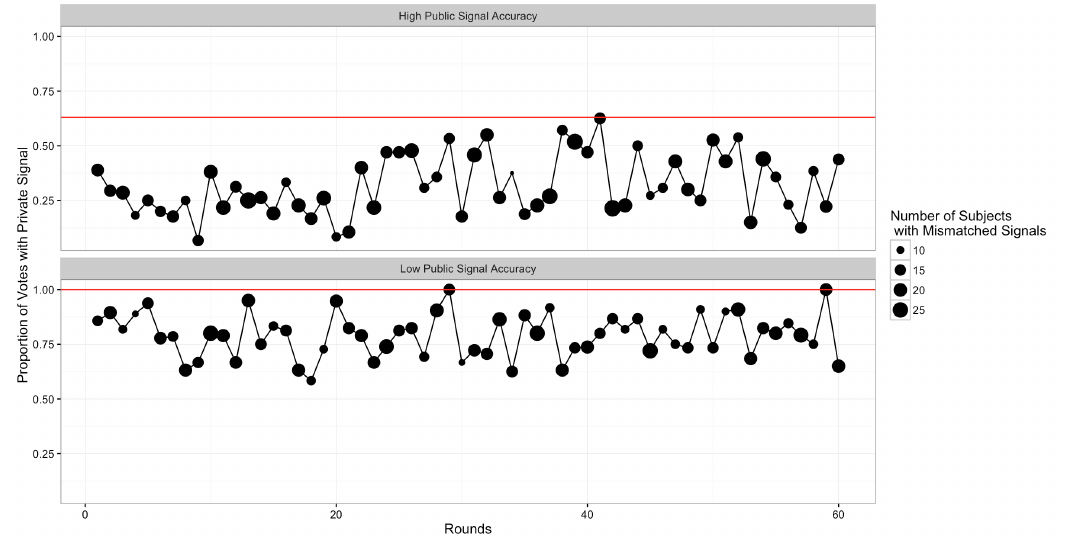
Figure A9. No Learning. This figure plot aggregate votes as a function of time (experimental rounds. Subjects’ behavior does not approach theoretical